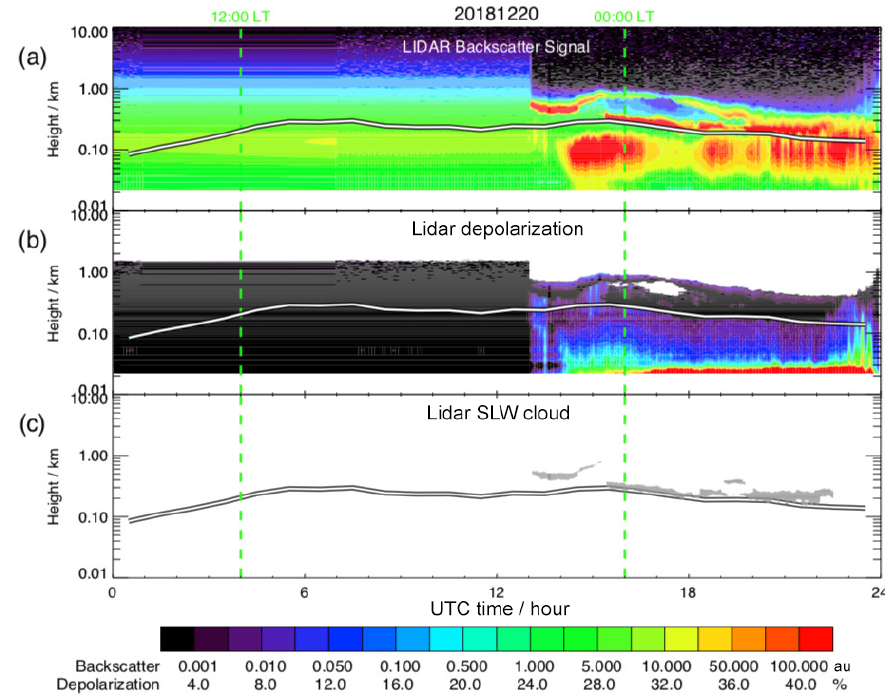
Figure 9. Same as Fig. 2 but for 20 December 2018.